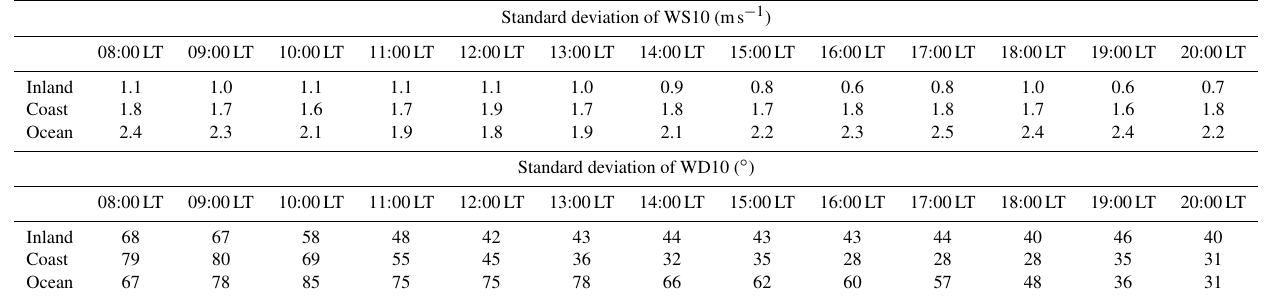
Figure 7. Similar to Fig. 6 but for the averaged corkscrew sea breeze events. Table 4. Standard deviation of WS10 and WD10 of the simulated corkscrew sea breeze